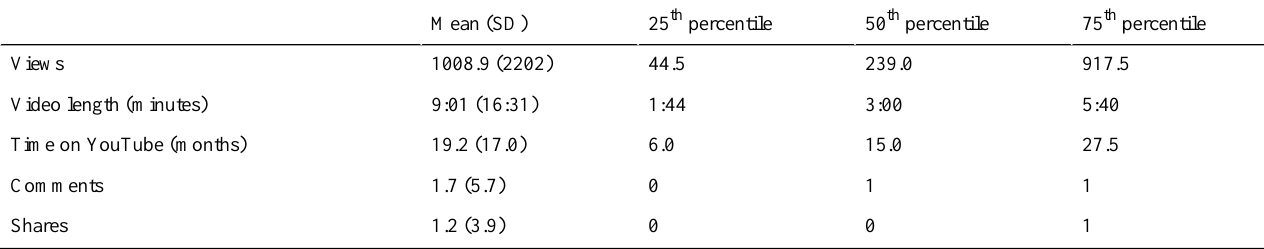
Table 3. Descriptive features of video results